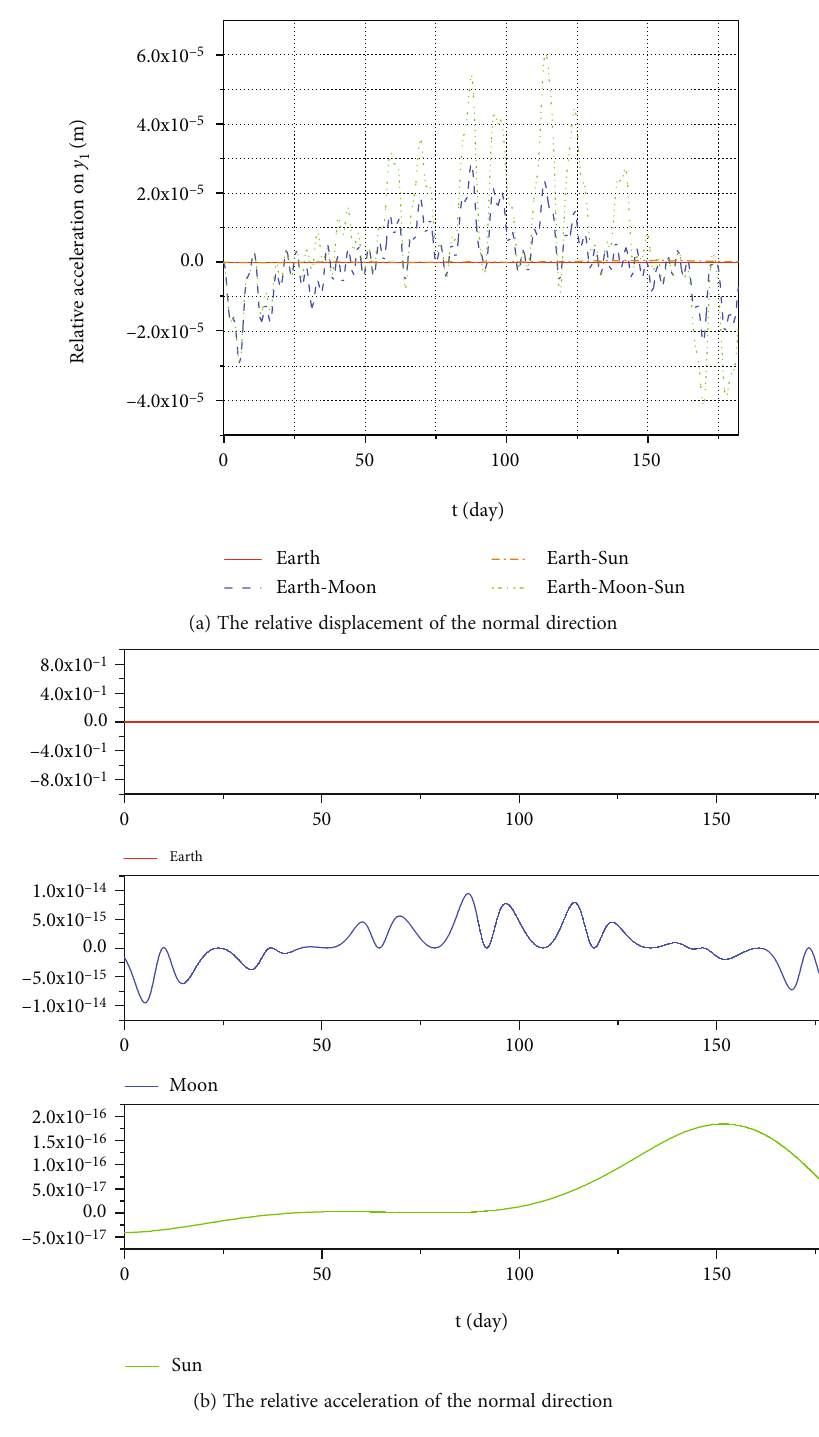
Figure 4: The e ff ect of the Earth-moon-sun system on the relative motion in the normal